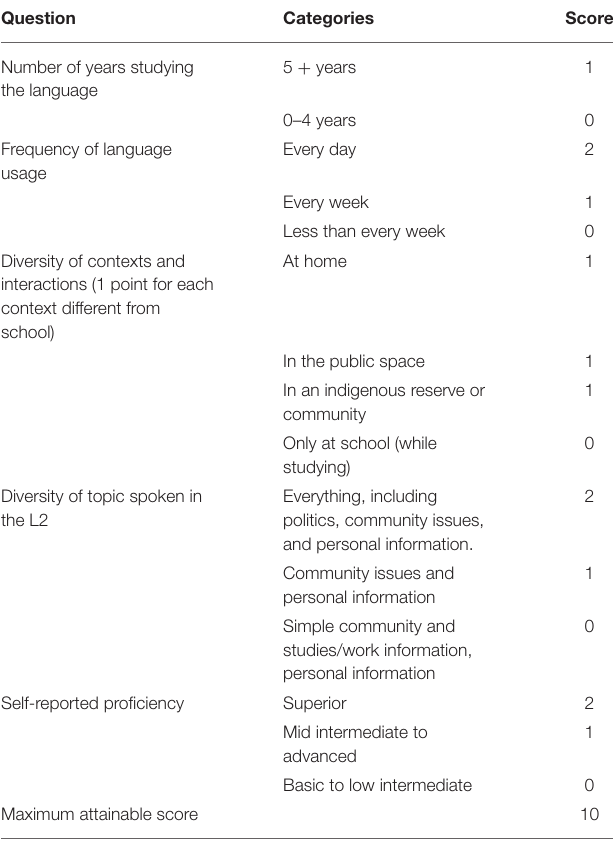
TABLE 1 | Questions and scores of the language background